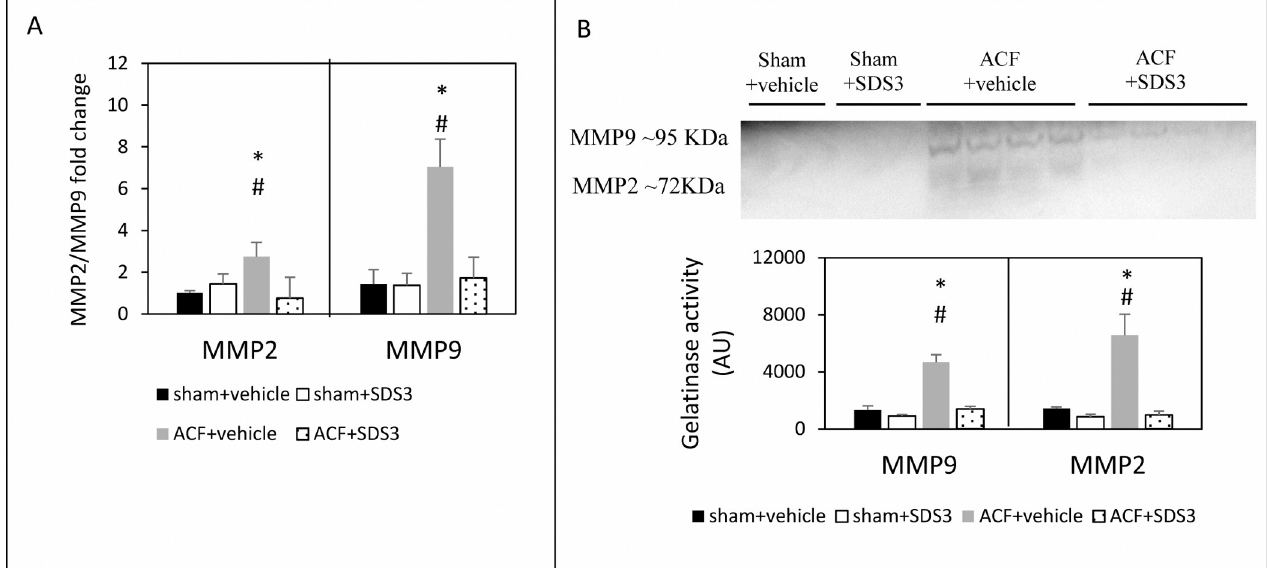
Fig 3. MMP9 and MMP2 expression and gelatinase activity with and without treatment with SDS3. (A) Relative MMP2 and MMP9 mRNA expression (sham-vehicle n = 6, sham-SDS3 n = 6, ACF-vehicle n = 6, ACF-SDS3 n = 8) and (B) gelatinase activity (sham-vehicle n = 2, sham-SDS3 n = 2, ACF-vehicle n = 4, ACF-SDS3 n = 4). Data are given as means ± SEM; � = P < 0.05 relative to sham + vehicle/sham+SDS3, # = P < 0.05 relative to